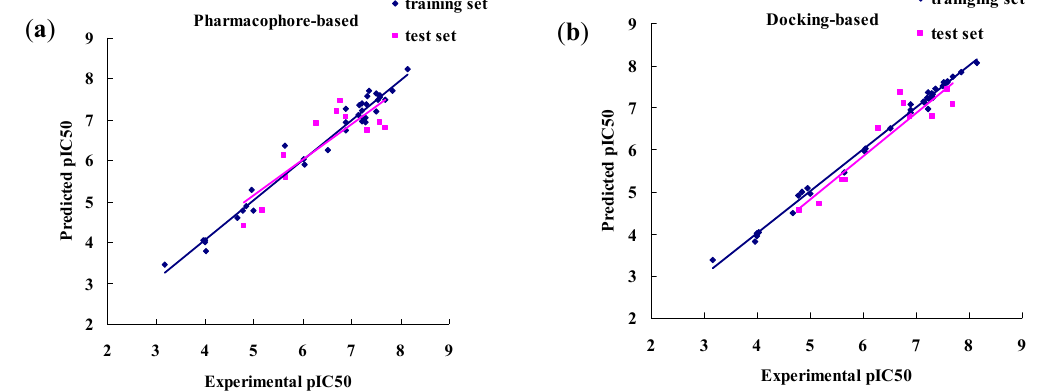
Figure 4. Graph of experimental values versus predicted values for training and test set compounds from CoMSIA-SEHD model. ( a ) For pharmacophore-based alignment, ( b ) for docking-based